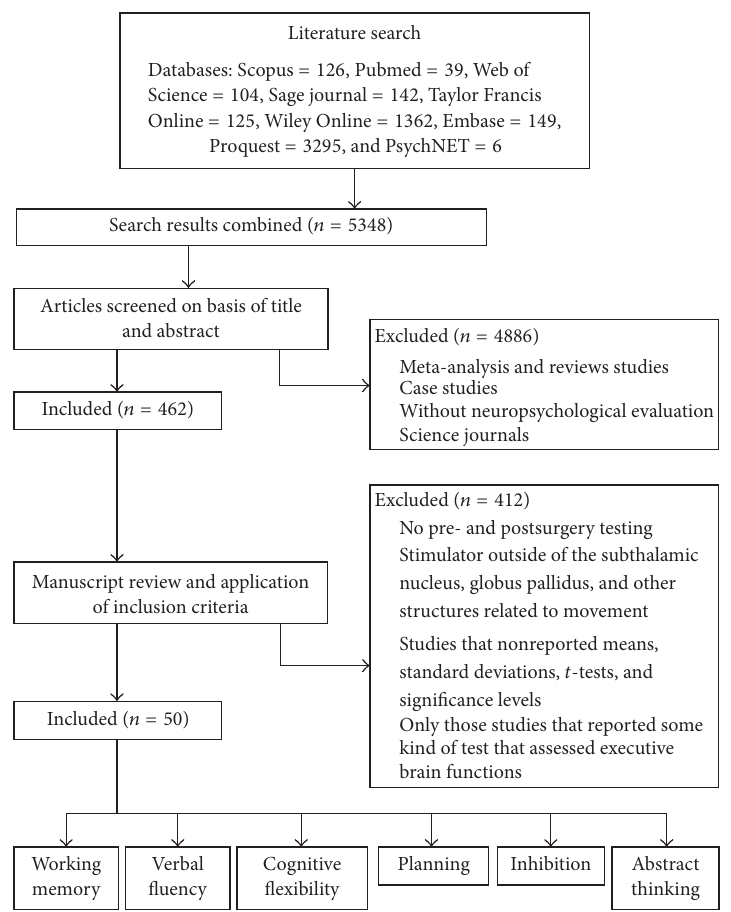
Figure 1: Flow diagram of study selection. Adapted from Liberati et al.